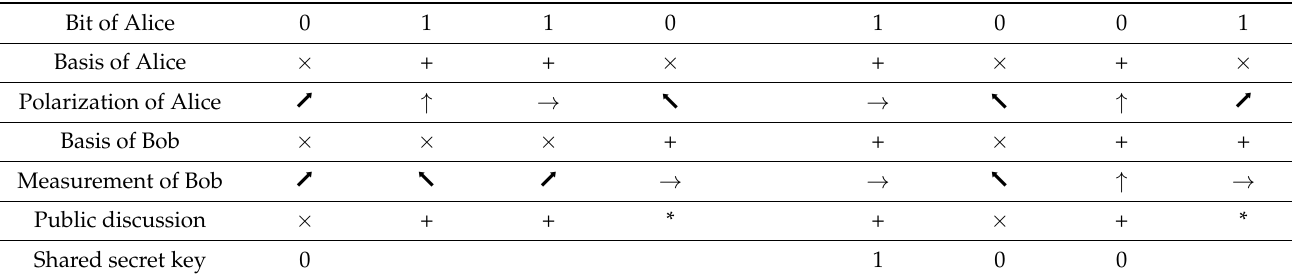
Figure 3. Results of the protocol CSLOE – 2022 work. Table 1. Sifted key.